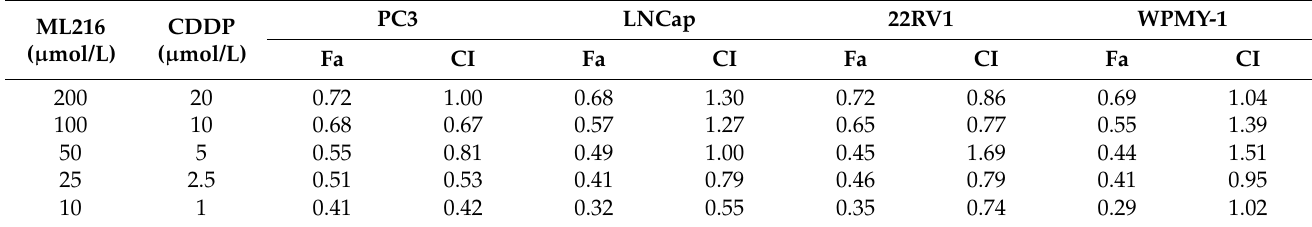
Table 1. Combination index (CI) of ML216 and CDDP in PC3, LNCap and 22RV1 cells.